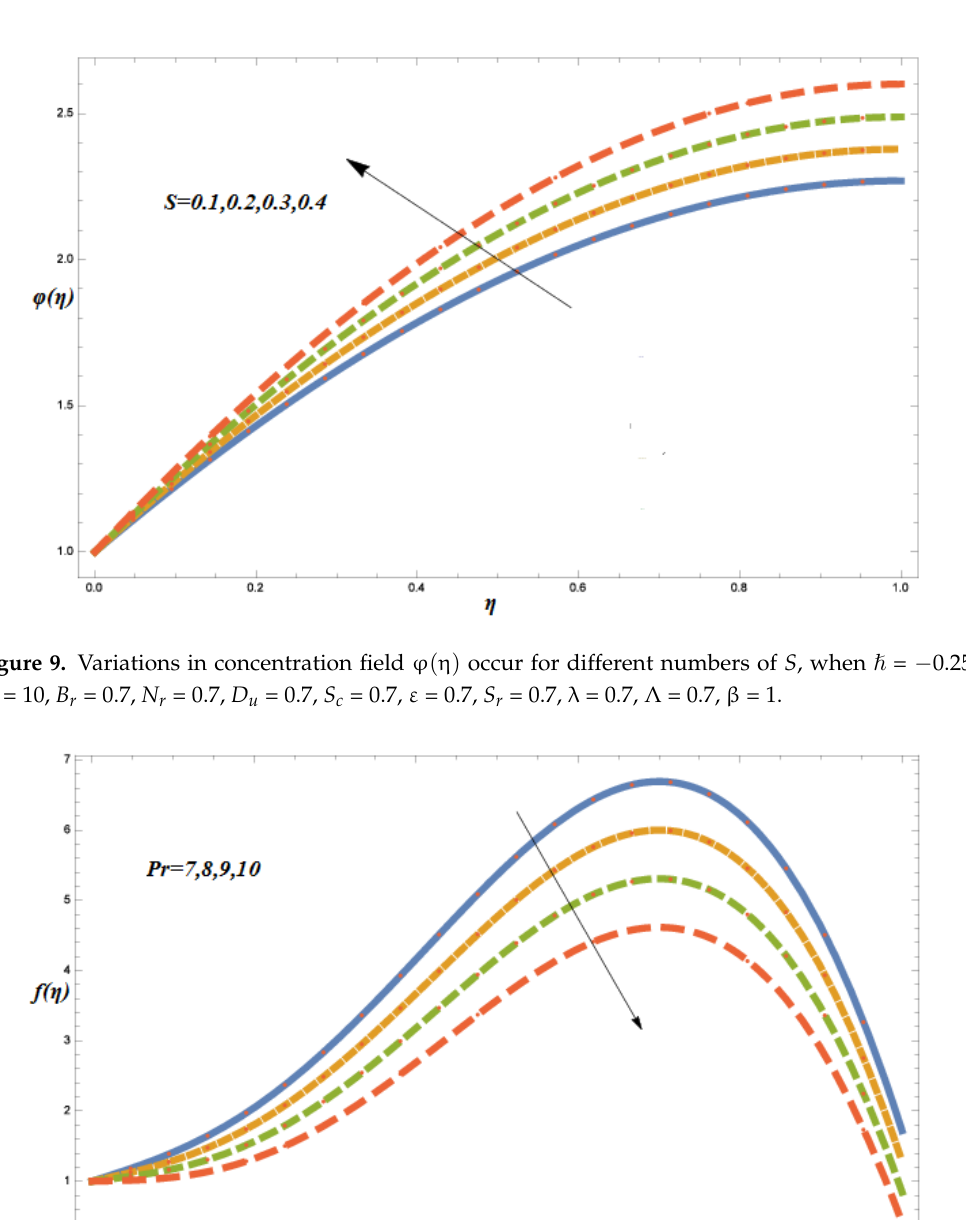
Figure 8. The variation of temperature scale gradient ( )   for different quantities of S , when  = − 0.25, P r = 10, B r = 0.7, N r = 0.7, D u = 0.7, S c = 0.7, ε = 0.7, S r = 0.7, λ = 0.7, Λ = 0.7, β = 1.